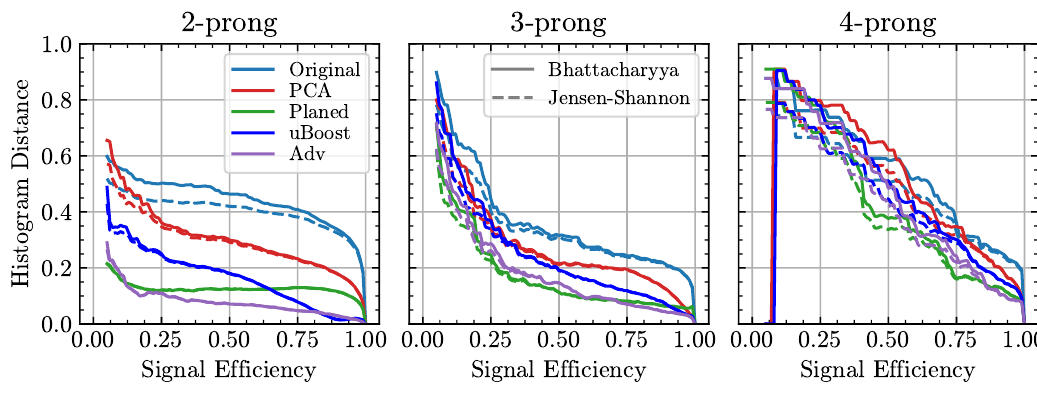
Figure 17: Comparison of Bhattacharyya distance and Jensen-Shannon distance for 2-, 3-, and 4-pronged signals, as a function of signal efficiency for various decorrela- tion methods studied in this work. The general trend for both metrics is seen to be the